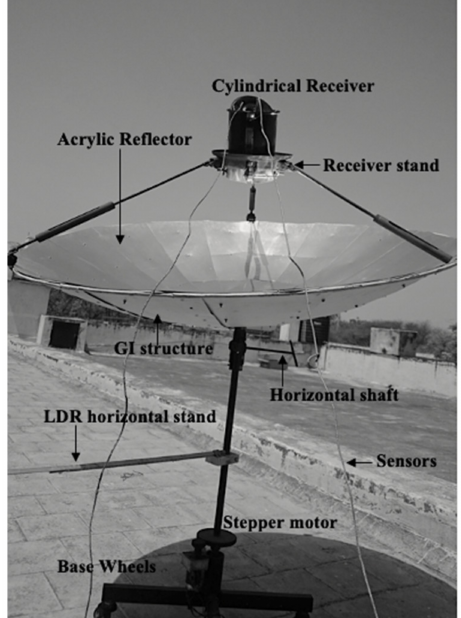
Figure 2. Details of dish components.